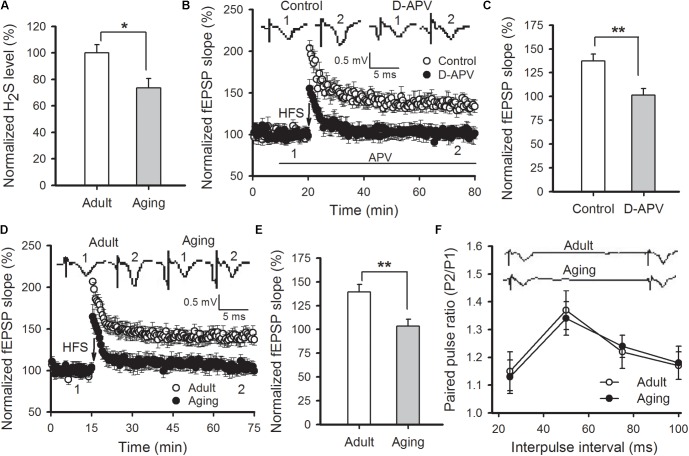
Aged rats display reduced hippocampal H2S level and impaired NMDAR-dependent LTP. (A) Amygdalar H2S levels were lower in aged rats in comparison to healthy adult rats (∗p < 0.05; n = 4 rats per group). (B) D-APV (50 μM) effectively blocked HFS-induced LTP in the thalamo-LA pathway of adult rats (n = 6–7 slices per group). (C) The mean EPSP slope, as depicted through histograms, from 50 to 60 min post-HFS in control and APV-treated slices (∗∗p < 0.01). (D) HFS failed to induce LTP in the thalamo-LA pathway of aged rats (n = 8 slices per group). (E) The mean EPSP slope, as depicted by histograms, from 50 to 60 min post-HFS in slices obtained from adult and aged rats (∗∗p < 0.01). (F) There was no significant difference in PPF between the healthy adult and aged rats (n = 6 slices per group). In (B,D,F), the insets are sample traces from the indicated times on the graph. All data are expressed as the mean ± SEM.